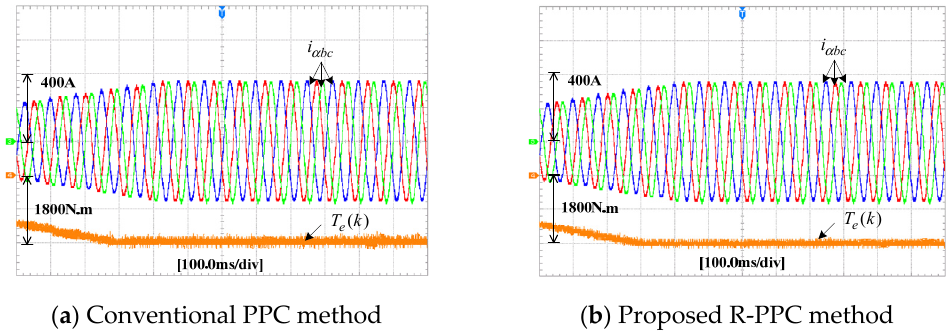
Figure 19. Experimental results of the phase current and torque under the discharge state. ( a ) Conventional PPC method; ( b ) Proposed R-PPC method.